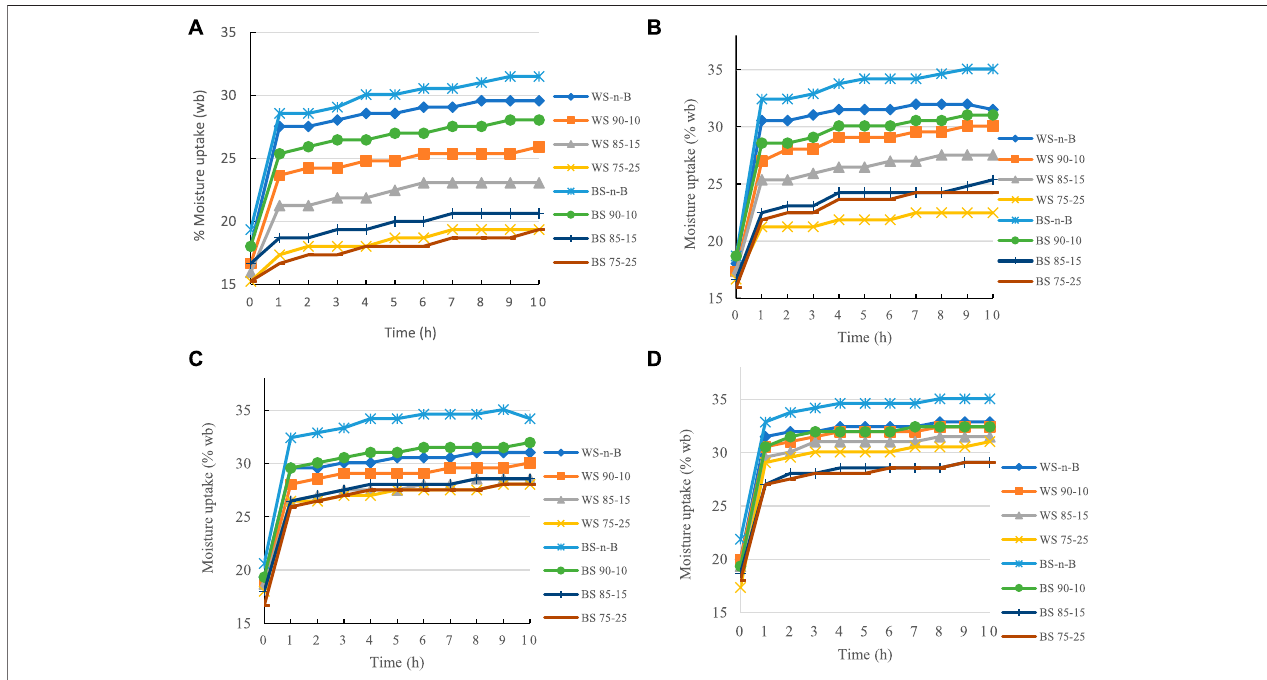
FIGURE8| MoistureadsorptionofpelletsmadeofMW-torre fi ed(wheatstrawbiocharandbarleystrawbiochar)pelletsat10%moisturecontentfordifferentHDPE binder levels (A) 6%; (B) 10%; (C) 20%, and (D) 25% at 6 ° C and 95% RH.